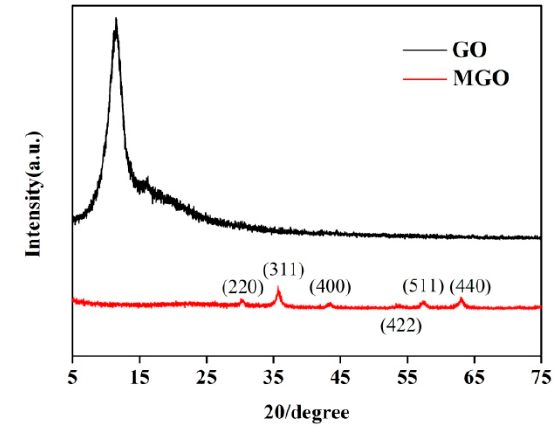
Figure 4. XRD pattern of GO and MGO.